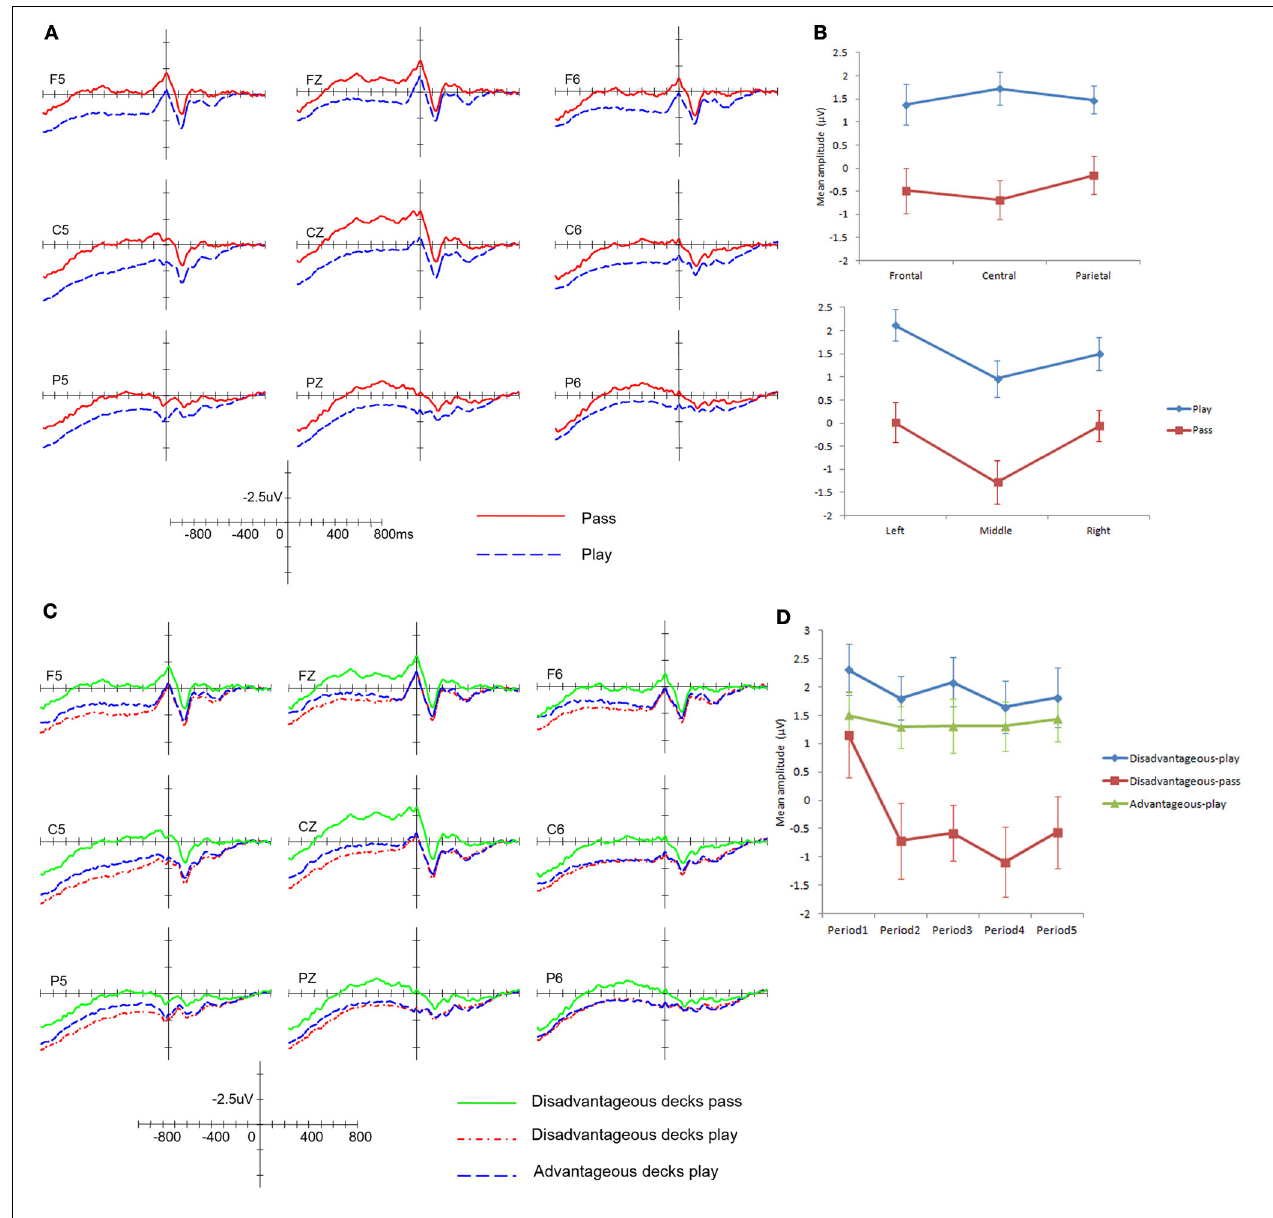
FIGURE 4 | ERP results in the response selection stage. (A) ERP modulations with different response types. (B) Decision Preceding Negativity amplitudes with different responses. (C) ERP modulations